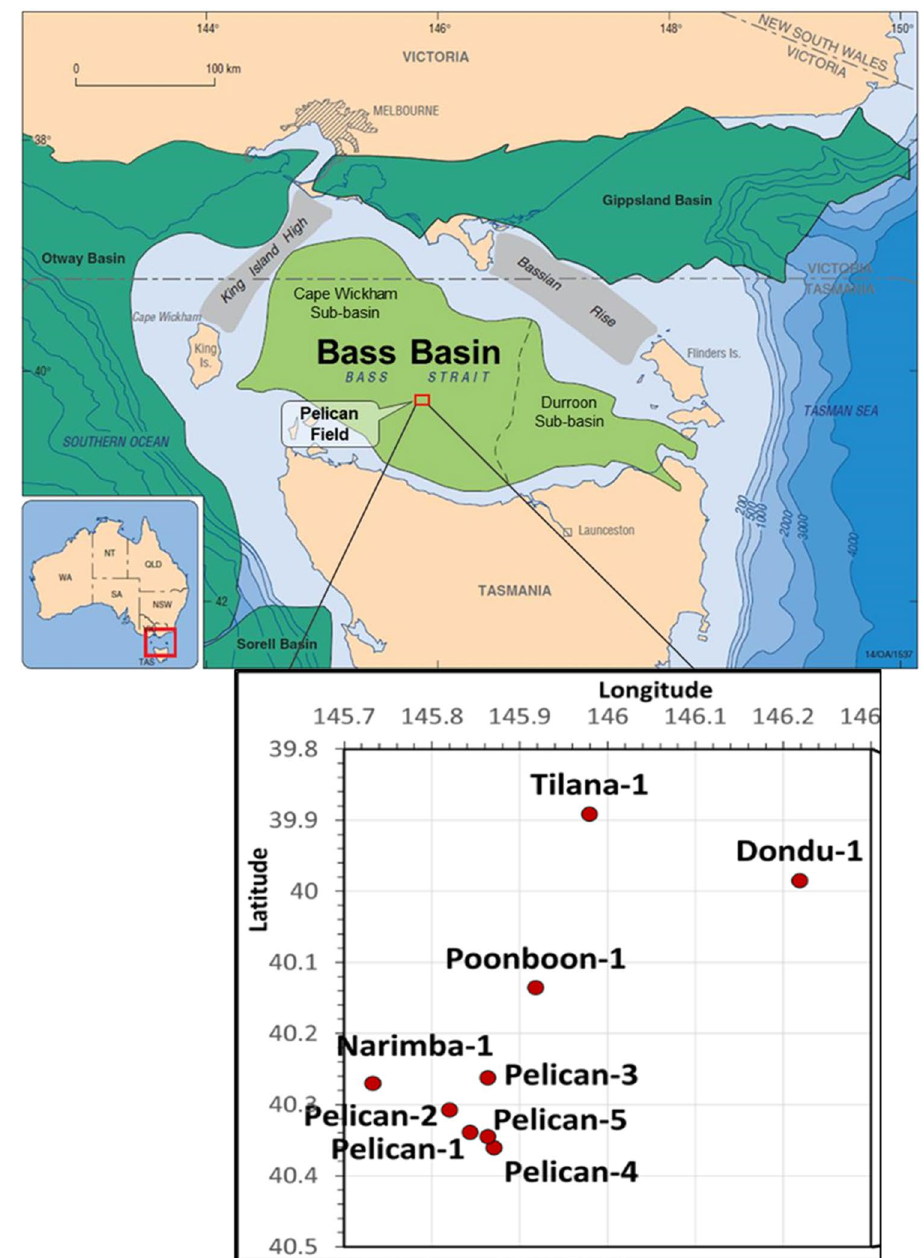
Fig. 1 Map showing the extent of the Bass Basin, highlighting the studied wells (modified after Boreham et al.